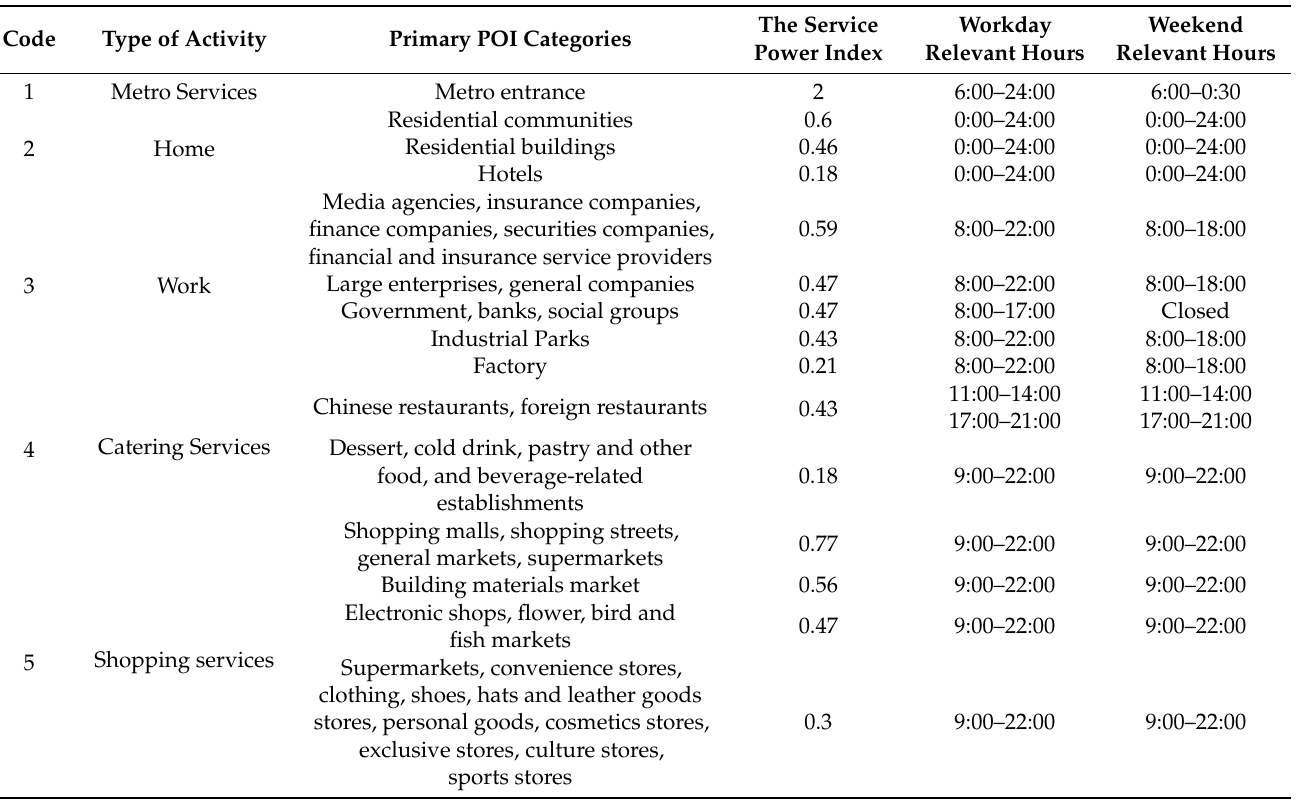
Table 1. Mapping between activity types and related POI categories, service power index, and operating schedule for POI